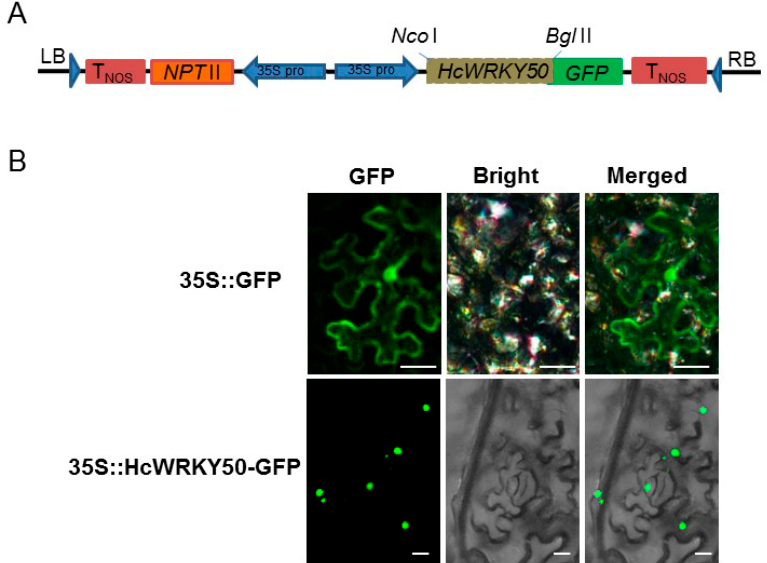
Figure 3. Subcellular localization of HcWRKY50-GFP fusion protein. ( A ) Schematic representation of the 35S:: HcWRKY50 -GFP fusion construct and the 35S::GFP construct. The HcWRKY50 CDS was fused into the GFP expression vector. ( B ) Subcellular localization of the 35S:: HcWRKY50 -GFP and 35S::GFP constructs was checked by a confocal laser scanning microscope. Scale bar = 20 μ